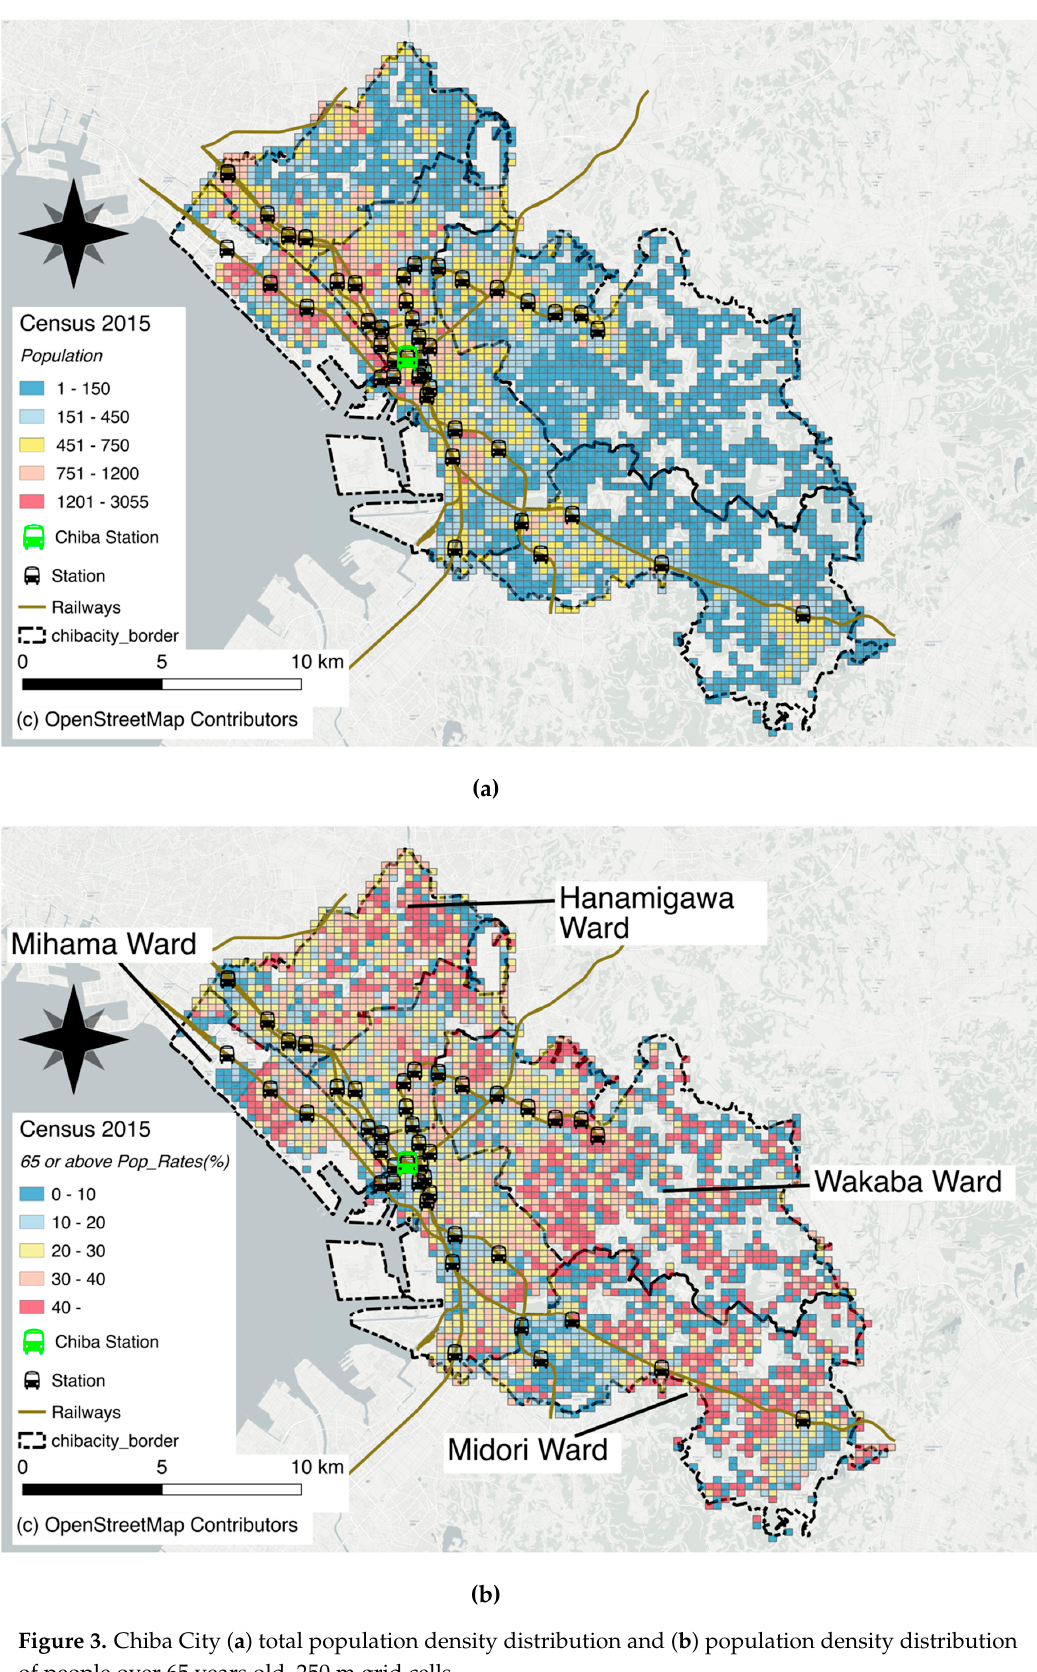
Figure 3. Chiba City ( a ) total population density distribution and ( b ) population density distribution of people over 65 years old, 250 m grid cells.